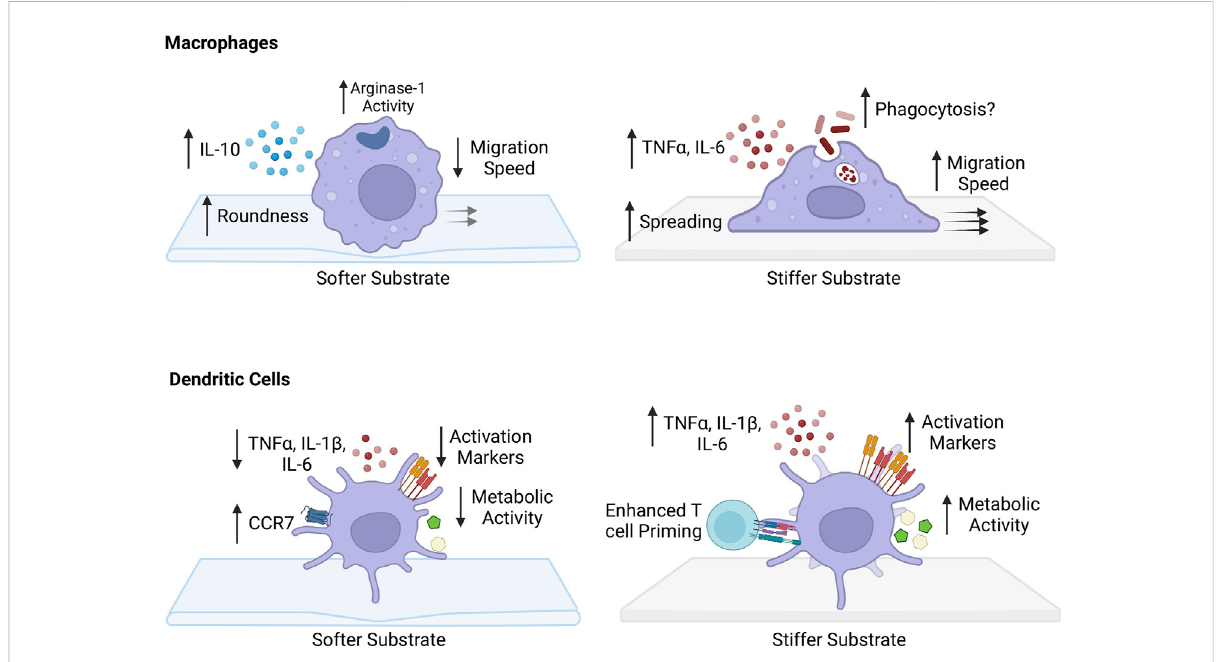
FIGURE 2 Impact of substrate stiffness on macrophages and dendritic cells. Softer substrates increase the roundness of macrophages. There is an increase PRM-like phenotype with an increase in IL-10 production and arginase-1 activity following IL-4 stimulation. Migration speed of macrophagesgrownonmorepliantsubstratesisdecreasedandpodosome-dependent.Macrophagesculturedonstiffersubstrateshaveastretched morphology, with increased pro-in fl ammatory phenotype and secretion of pro-in fl ammatory cytokines TNF- α and IL-6. Phagocytosis capability has been suggested to increase, but still remains unclear. They acquire afast, podosome-independent mode of migration after growth on stiffer surfaces. Dendritic cells (DCs) grown on softer substrates appear to have enhanced migratory capacity with increased expression of chemokinereceptor 7(CCR7). Thereis adecreased ability to produce pro-in fl ammatory cytokines TNF- α , IL-1 β , and IL-6, and decrease inactivation state. Metabolically, there is a decrease in glycolytic capacity. DCs cultured on stiffer substrates have greater ability to prime CD4 + and CD8 + T cells. They have increased capability to produce TNF- α , IL-1 β , and IL-6 and have an enhanced activation state with increased expression of CD80/86 and CD40. Metabolically, they have increased glyocolytic capacity and express more intermediates of